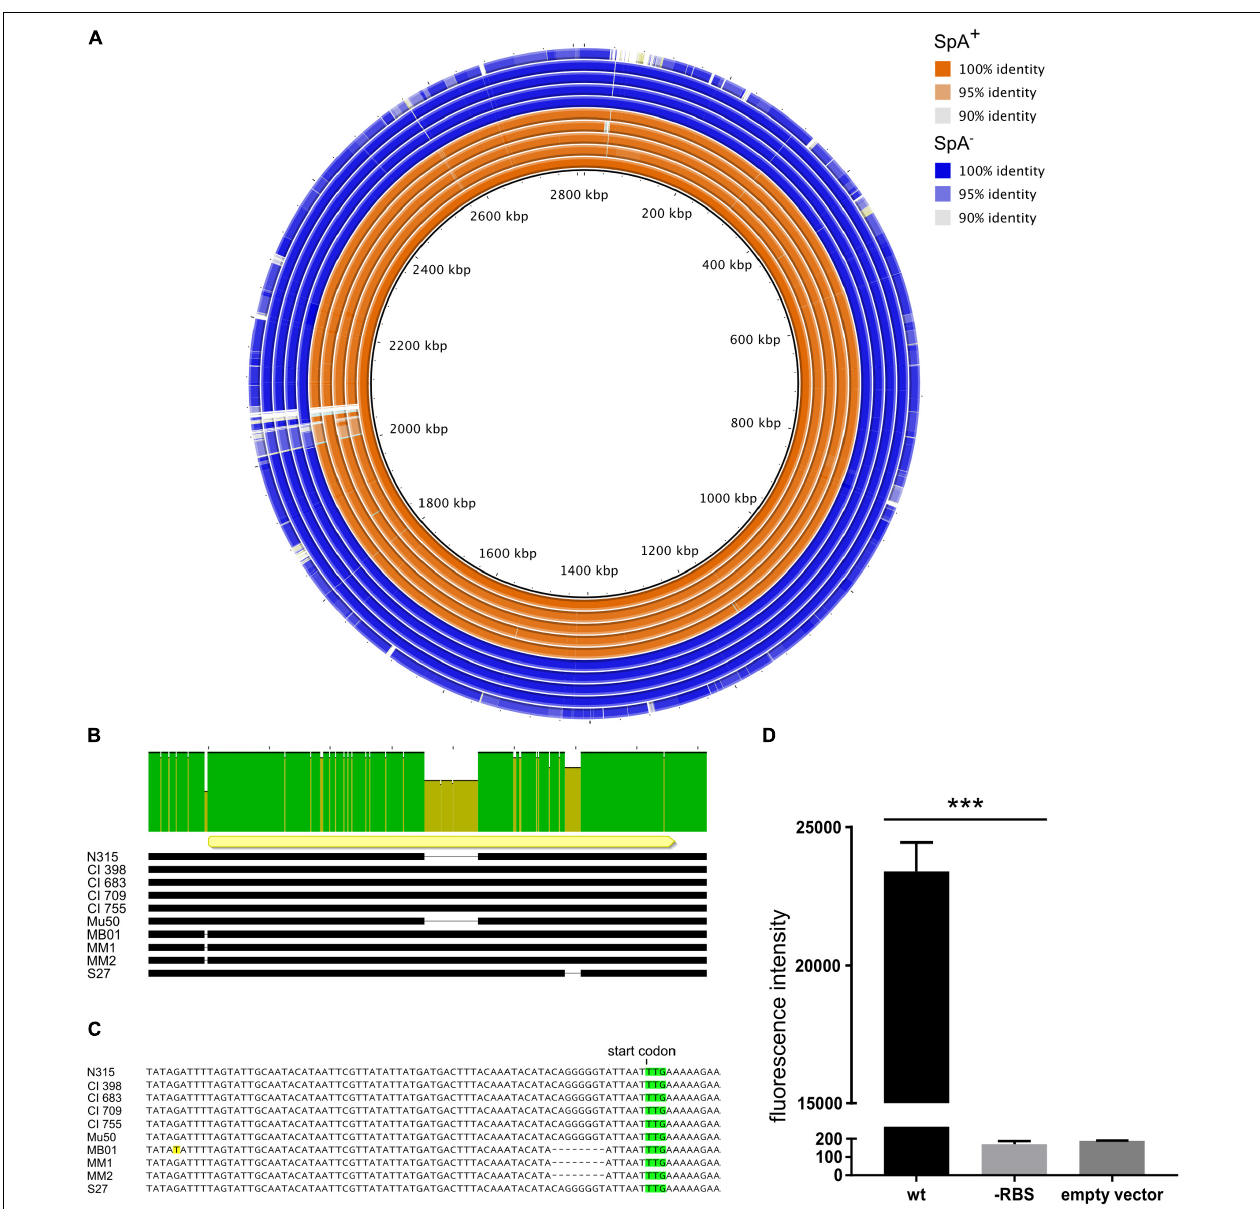
FIGURE 2 | Genetic differences of SpA + and SpA - strains. (A) Comparative genomic analysis using N315 as reference (inner circle). The figure shows the genetic identity between the strains and the N315 reference strain. The SpA + strains are depicted in orange, the SpA - strains in blue. White gaps show regions present in the reference strain but absent in the analyzed genomes. The analyzed strains are, from the inner circle to the outer circle, N315, CI398, CI683, CI709, CI755, Mu50, MB01, MM1, MM2, and S27. (B) Alignment of spa locus in the subset of strains. The upper bar highlights the sequence identity of the spa locus. The yellow arrow shows the position and orientation of the spa coding sequence. The black bars represent the sequence in each strain and the gaps correspond to deletions. (C) Magnification of the region upstream of the coding sequence of spa . The start codon is highlighted in green and the mismatch present in the MB01 sequence is highlighted in yellow. The dashed gaps underline the deletion present in the 5 (cid:48) UTR region of the spa gene in MB01, MM1, and MM2 strains. (D) Effect of the 5 (cid:48) UTR mutation on reporter production. The graph shows the fluorescence signal obtained from overnight growth of E. coli transformed with pOS1 plasmid containing either the wt spa promoter, or carrying the RBS mutation fused to mCherry reporter gene. The empty vector control shows the signal from E. coli strain transformed with pOS1 backbone. The graph represents three independent experiments from different clones and statistical significance was calculated by an unpaired t -test with Welch’s correction, ∗∗∗ p <